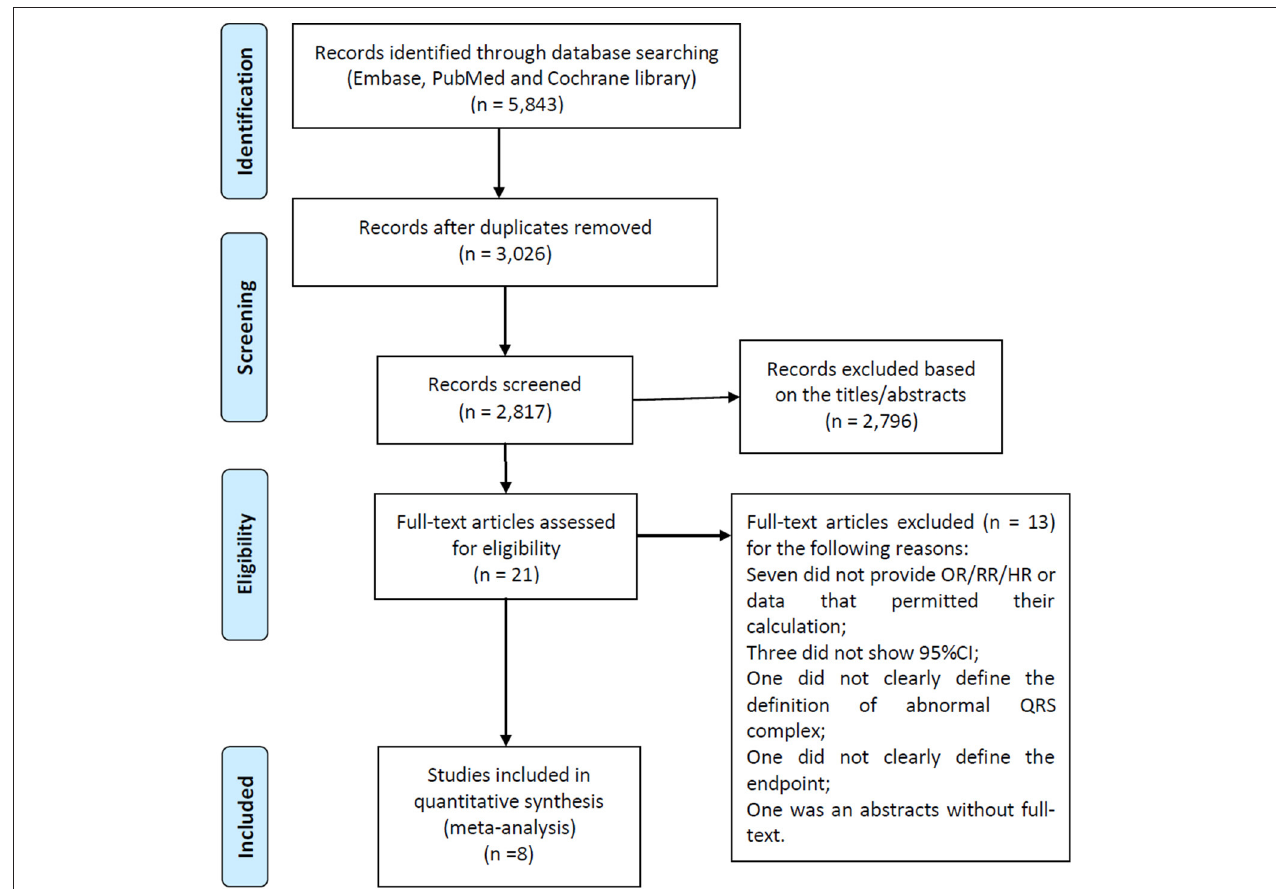
FIGURE 1 | Flow diagram of the study selection